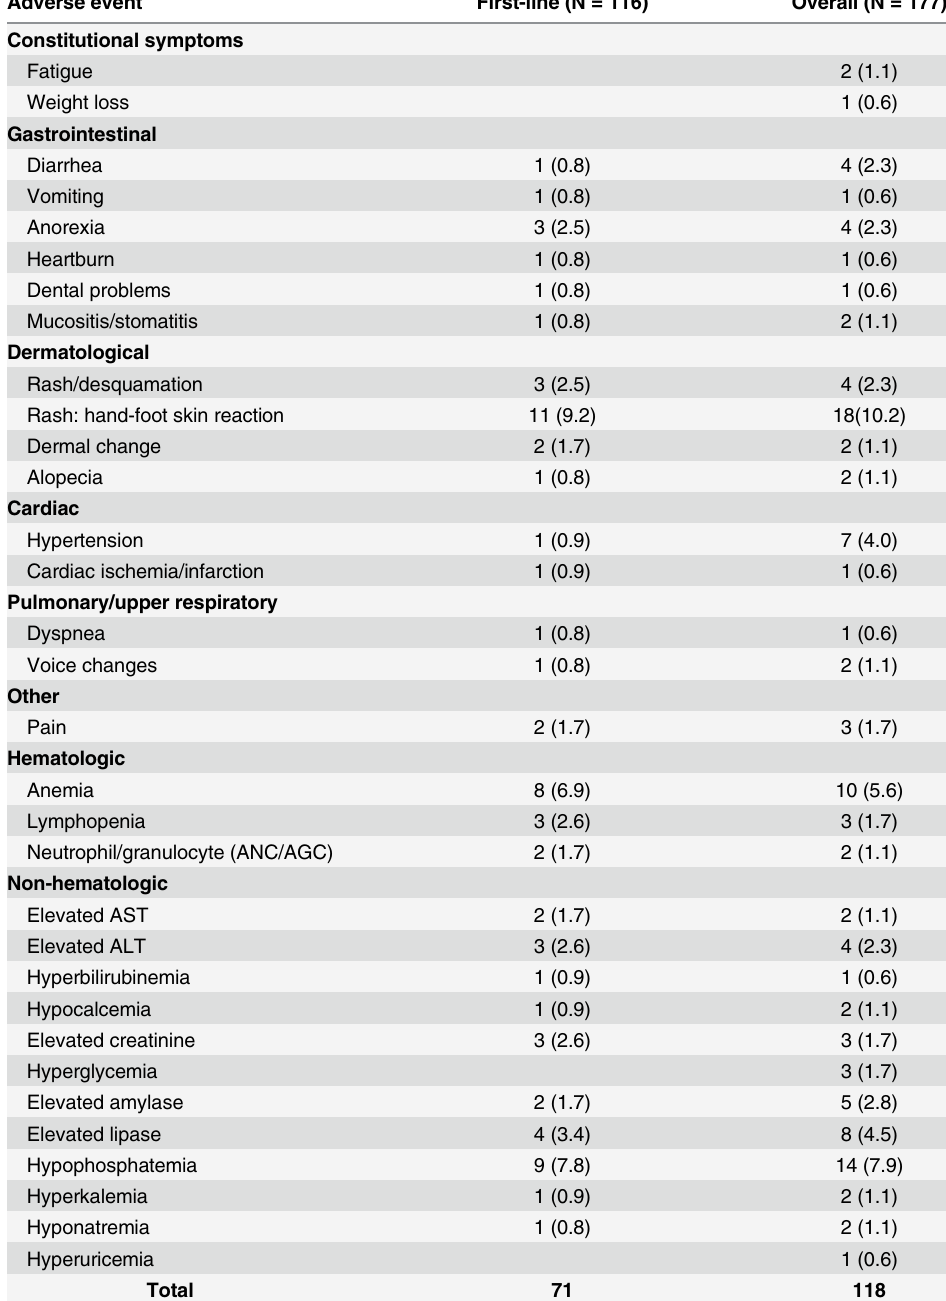
Table 2. Description of (cid:1) graded 3 adverse events during sorafenib treatment (N,%) (See also S1 Table, for more